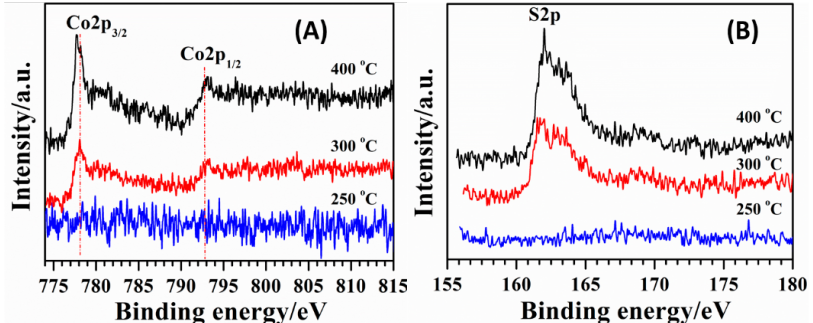
Figure 4. X-ray Photoelectron Spectroscopy (XPS) spectra of ( A) Co2p and ( B ) S2p for CoS samples obtained at different annealed temperatures from 250 to 400